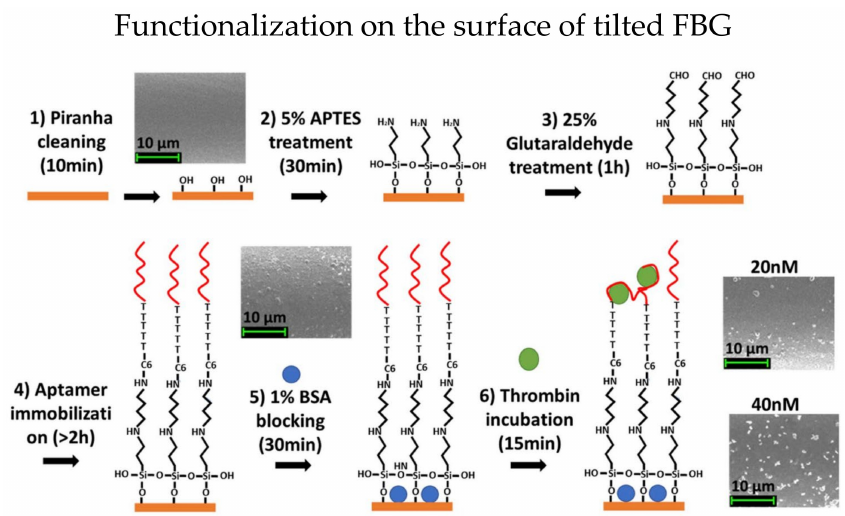
Figure 3. Functionalization steps of etched TFBG for thrombin detection. Reprinted with permission from Ref. [40]. Copyright 2015,